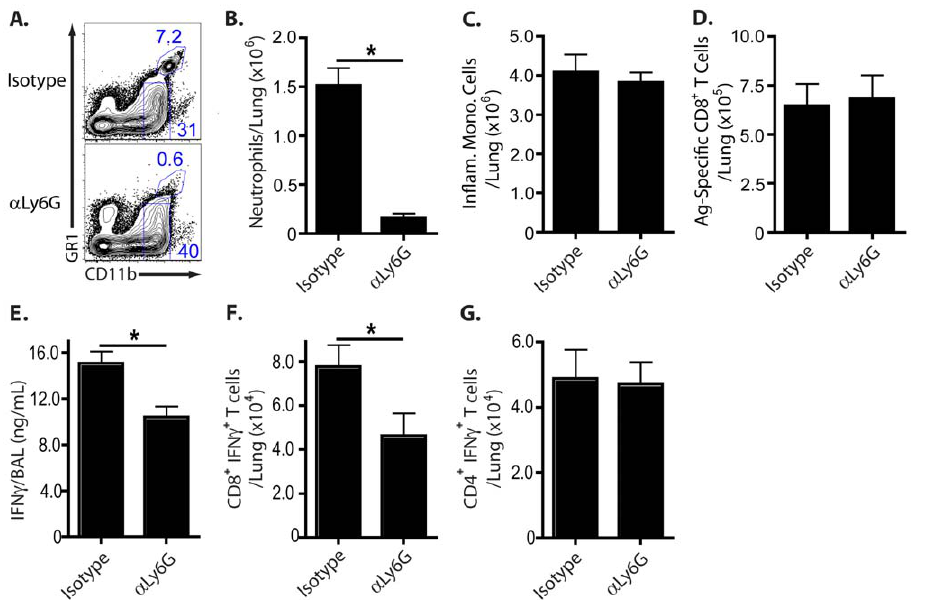
Figure 6. Neutrophils trigger CD8 + , but not CD4 + , T cell anti-viral activity invivo . ( A–G ) BALB/c mice were infected with PR8 (0.1LD 50 ) and at 5 dpi, were administered 500 ug isotype or a Ly6G depleting antibody i.p.. Lung tissue/BAL fluid was collected twenty-four hours later. ( A ) Representative flow profile depicting neutrophil depletion (previously gated as CD45 + Thy1.2 2 ). Absolute number of lung ( B ) neutrophils, ( C ) inflammatory mononuclear cells, and ( D ) antigen-specific CD8 + T cells in isotype or depleting antibody treated mice. ( B ) Neutrophils were gated as CD45 + , GR1 hi , CD11b hi , FSC lo , SSC int and ( C ) inflammatory mononuclear cells as CD45 + , Ly6C hi , GR1 int/lo , CD11b hi ,MHC II hi . ( D ) Antigen-specific CD8 + T cells was estimated following in vitro re-stimulation with influenza-infected target cells (P815) and analysis of IFN c + CD8 + T cells via flow cytometry. ( E ) IFN c content in sample BAL fluid. ( F–G ) Six hours prior to harvest, monensin was administred i.p. to mice ( in vivo ICCS assay). The number of ( F ) CD8 + or ( G ) CD4 + T cells producing IFN c with and without neutrophil depletion is depicted. ( A–D ) Three independent experiments (n=2–3/expt) represented as mean 6 SEM (where applicable). Considered statically significant at P , .05 (*).